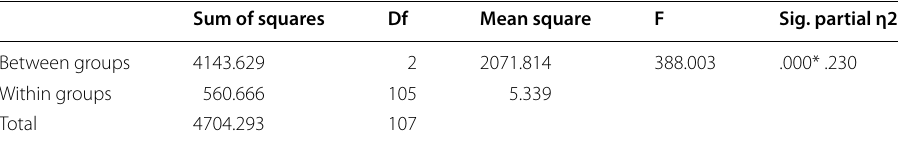
Table 7 Post-hoc multiple comparison: pretest, the immediate and delayed posttest scores (I)group (J)group Mean Pretest Immediate posttest